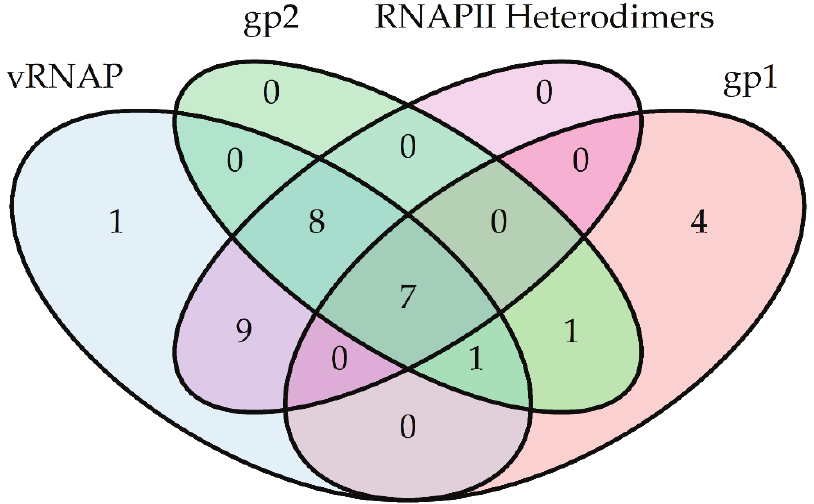
Figure 8. Venn diagram of species containing homologs of N4-encoded early and middle transcriptional machinery proteins vRNAP (blue), gp2 (green), gp1 (pink), and N4 RNAPII (purple) identified by DELTA-BLAST of NCBI RefSeq proteins. For simplicity, the category of species containing single-subunit RNAPs homologous to N4 RNAPII has been excluded. The number of species within each cross-section is